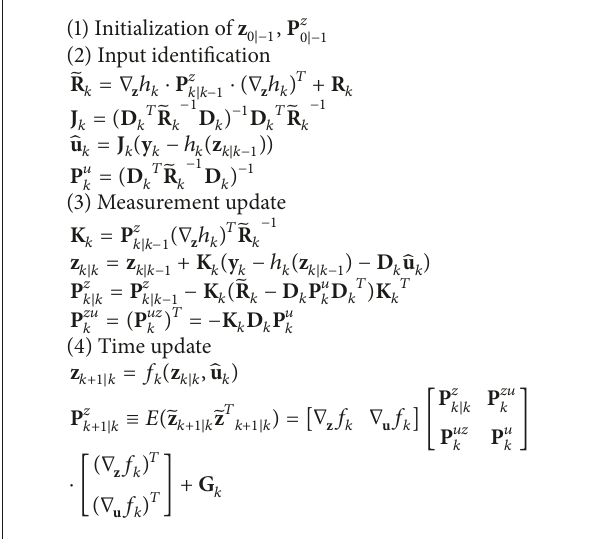
Algorithm 2: The algorithm of